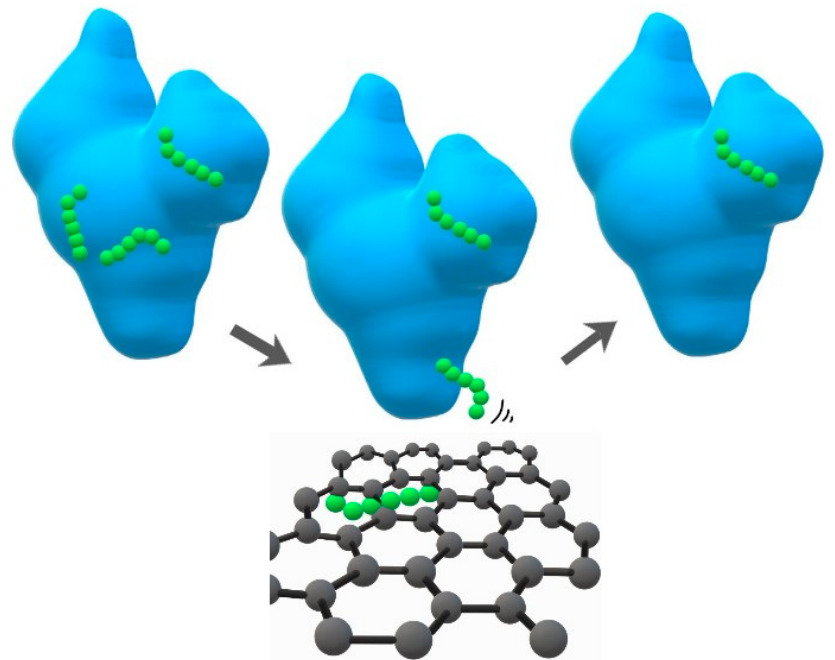
Figure 1. The schematic representation of spontaneous desorption (from albumin)–adsorption (on carbon surface) process of excess FAs. Blue mass indicates the albumin molecule. Each string of beads in green color represents the FA molecule. Black surface consisting of hexagonal structure represents the carbon electrode. When the albumin molecule comes into contact with the carbon electrode surface, the excess FA desorbs from the albumin and adsorbs on the electrode surface.